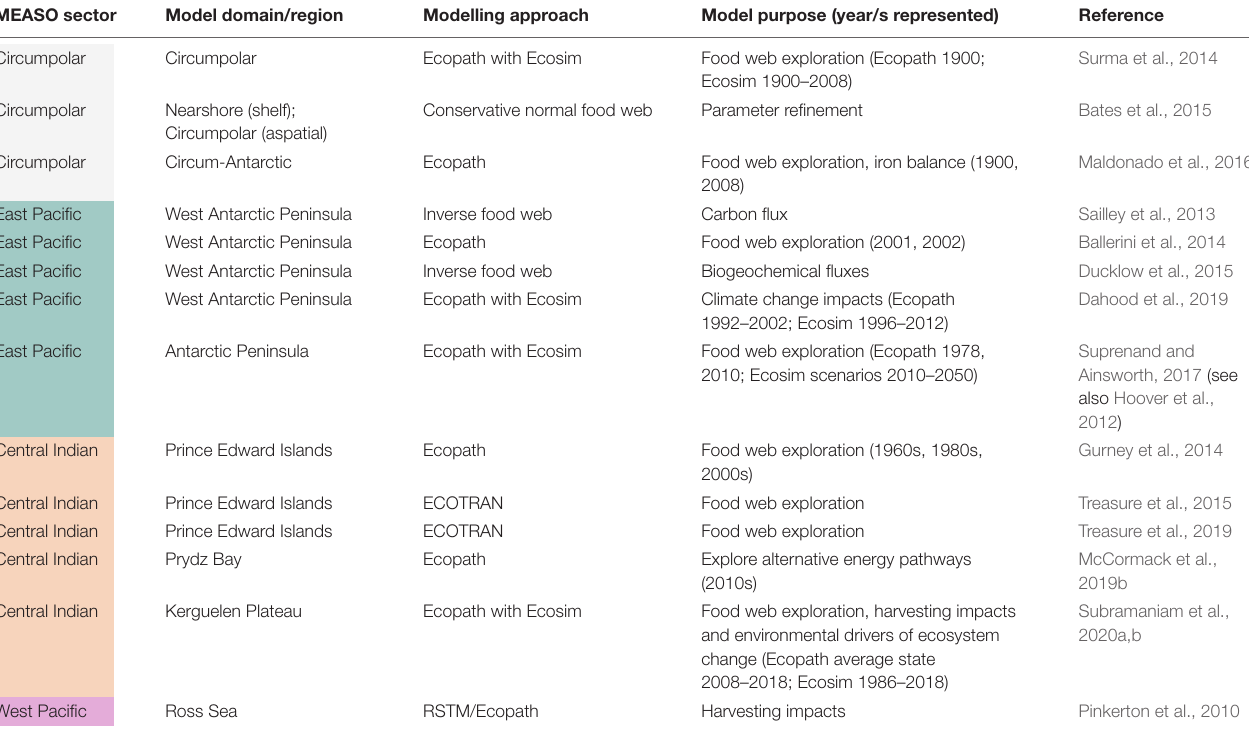
TABLE 3 | Examples of Southern Ocean EwE and whole-of-food web models published since 2012 (not fully